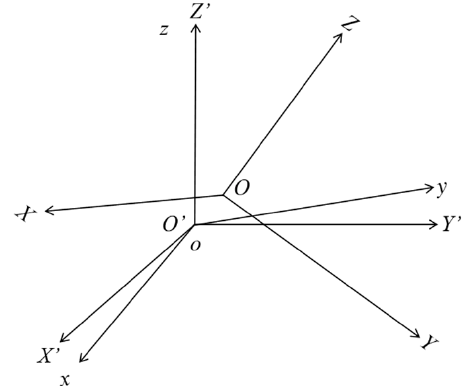
Figure 1. Coordinate system.